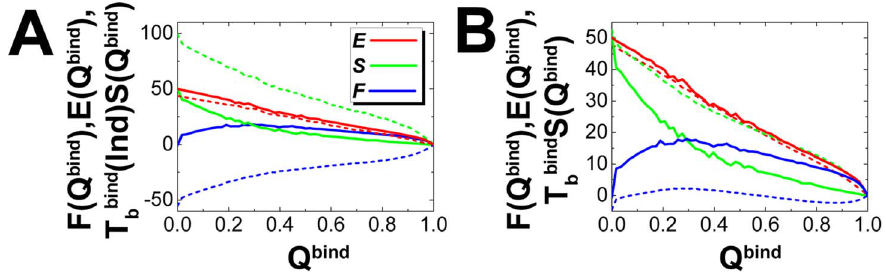
Figure 2. The energy, entropy and free energy of rigid and flexible binding for Lambda Cro repressor. The profiles are plotted at (A) rigid binding temperature ( T bind ( Ind ) ), and (B) corresponding rigid and flexible binding transition temperature ( T bind b energy are in reduced unit.